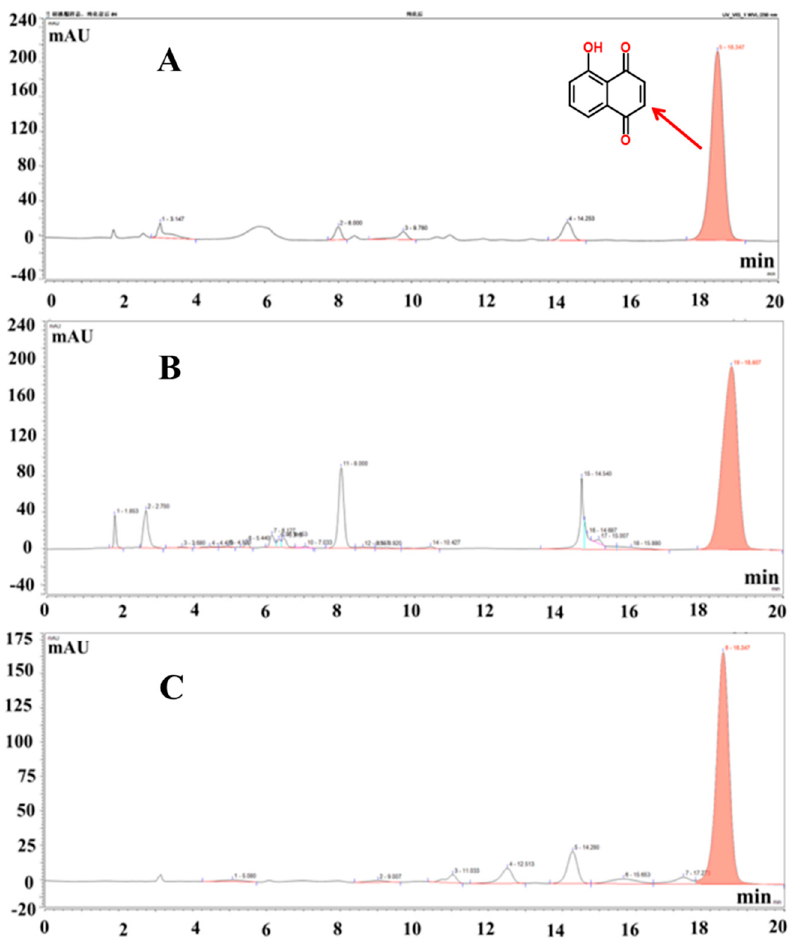
Figure 1. The HPLC chromatograms of the juglone standard ( A ), extracted juglone crude ( B ), and purified juglone ( C ). Elution time is shown on the horizontal axis, and electrical signal strength is shown on the vertical axis.